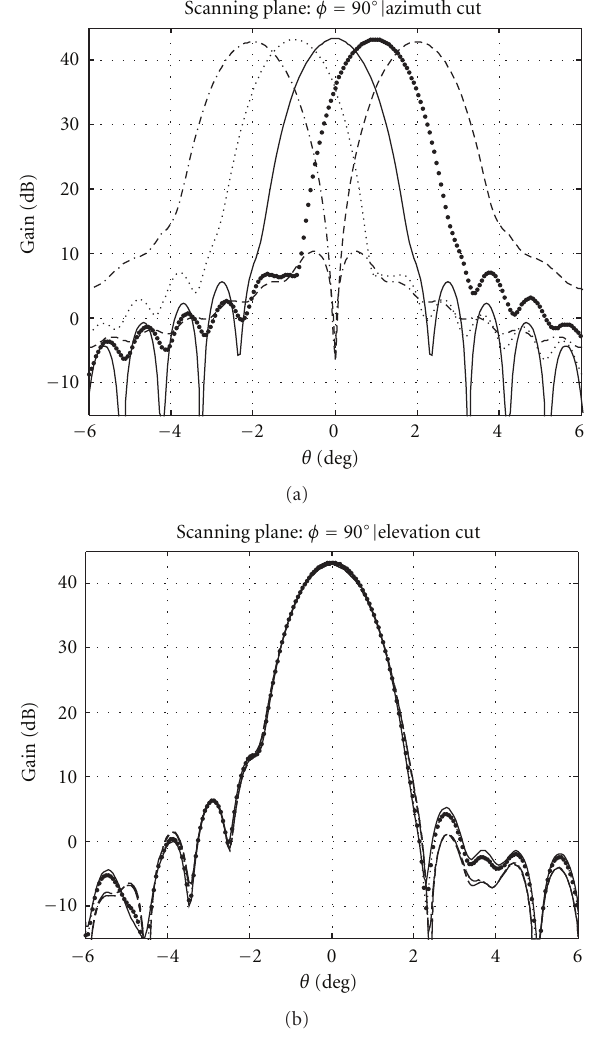
Figure 2: Simulated patterns of the dual-reflector antenna at 11.95 GHz for beam scanning in azimuth in the principal planes. (a) Azimuth plane, (b) elevation